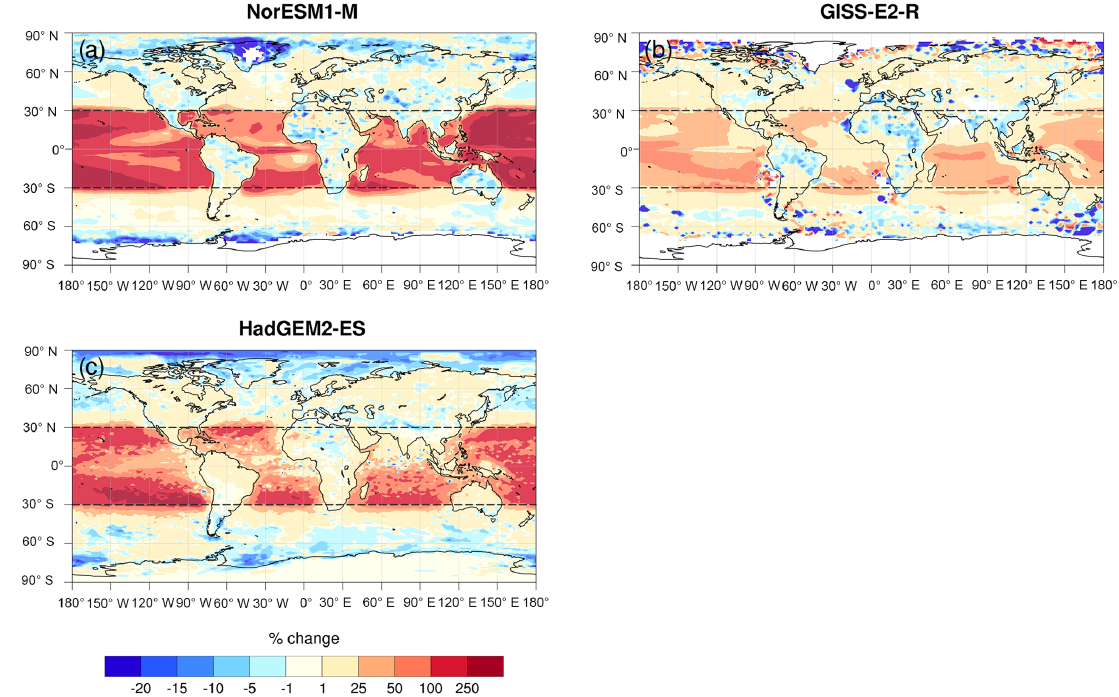
Figure 7. Mean relative change in CDNC due to sea salt injection for NorESM1-M (a) , GISS-E2-R (b) , and HadGEM2-ES (c) . CDNC rep- resents the cloud droplet number concentration within the model layer below 700hPa with maximum concentration, and the maps represent averages over